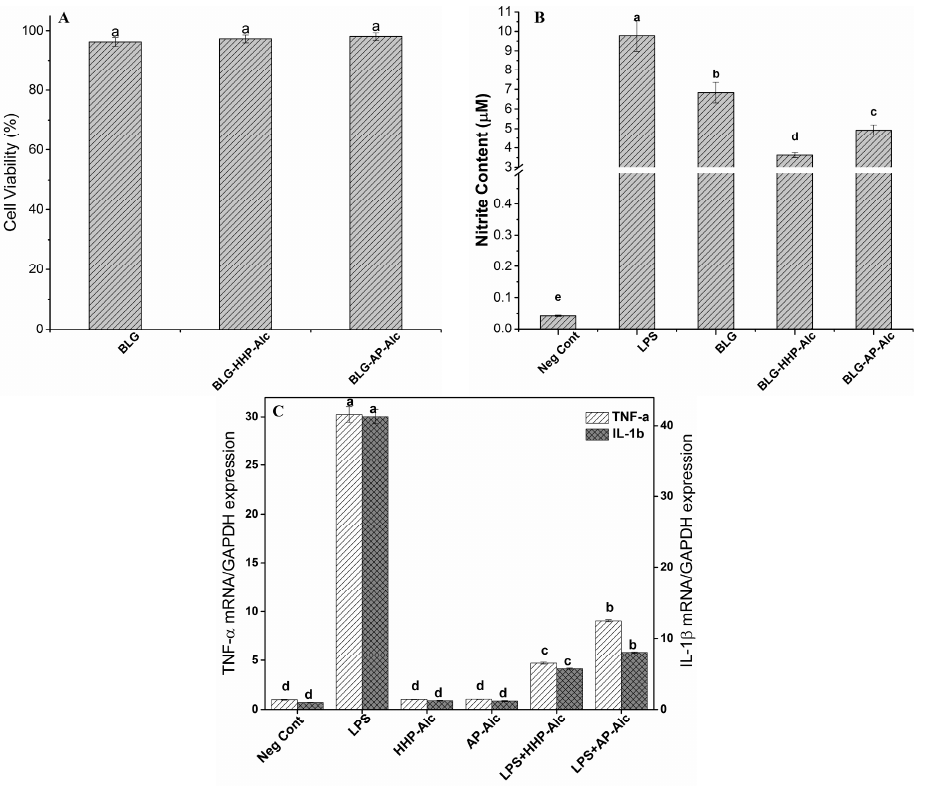
Figure 4. ( A ) Viability of RAW 264.7 cells; ( B ) Nitric oxide content of RAW 264.7 cell supernatant and ( C ) mRNA expression of pro-inflammatory cytokines (tumor necrosis factor (TNF- α ) and IL-1 β ) relative to glyceraldehyde 3-phosphate dehydrogenase (GAPDH) ( ∆∆ C t ) in lipopolysaccharide (LPS)-stimulated RAW264.7 macrophage cells in the presence of intact β -lactoglobulin (BLG) and BLG hydrolysates produced by alcalase under HHP and AP conditions (BLG-HHP-Alc and BLG-AP-Alc). The Negative Control indicates the cells grown without any treatment. The Positive Control indicates the cells treated with LPS, without treatment. The bars and error bars represent means and standard errors, respectively ( n ≥ 3). Means with different lowercase letters differ significantly ( p < 0.05).